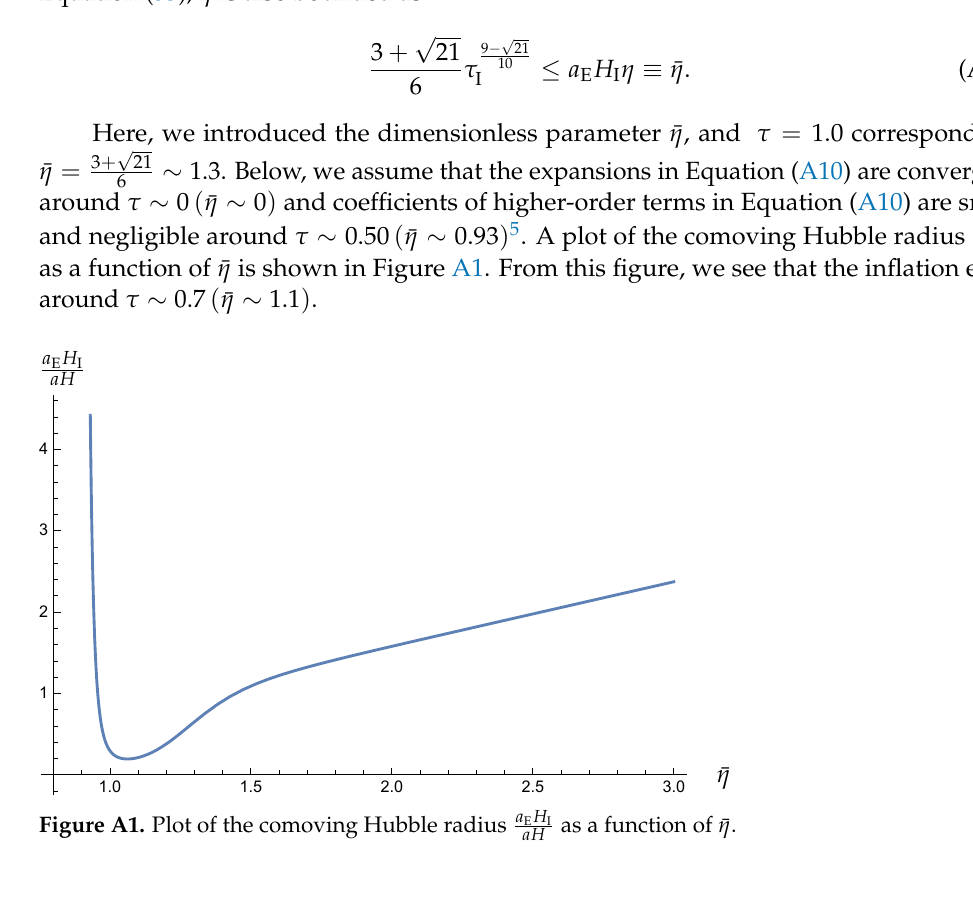
Figure A1. Plot of the comoving Hubble radius a E H I